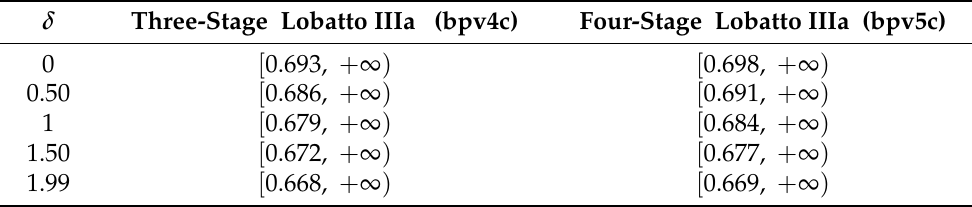
Table 8. Ranges of θλ 2 ensuring convergence without ghost solutions (Three-/Four-Stage Lobatto IIIa).